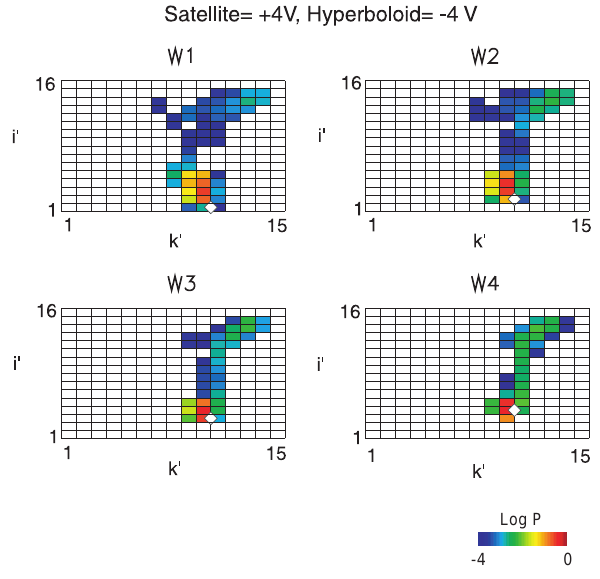
Fig. 8. Incoming direction probabilities for windows 1 to 4 in the energy range 6.0–9.0eV used in correcting ion distributions. Maps are interpolated, the new angular resolution is 24 ◦ × 10 ◦ pixels ac- cording to the data